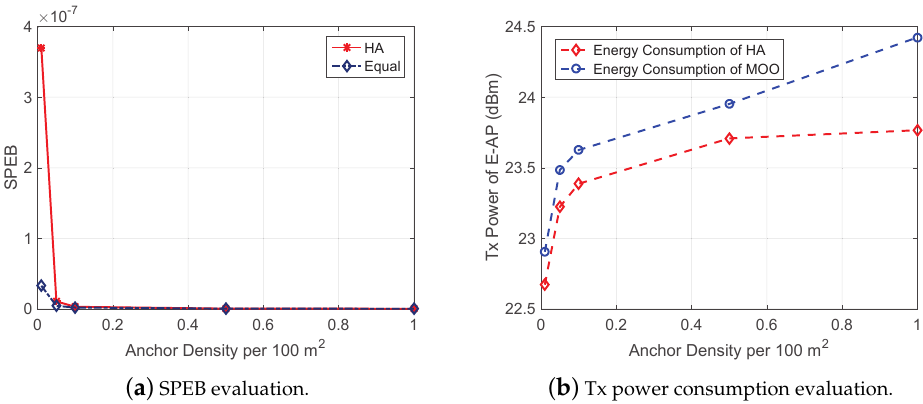
Figure 5. Performance evaluation of different anchor